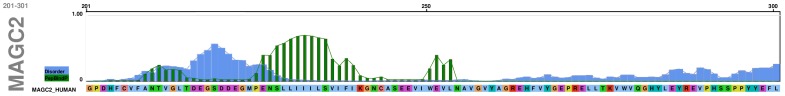
PepBindPred output for Q9UBF1 (MAGC2_HUMAN).Melanoma-associated antigen C2; Motif: LLIIILSVI, residues 229–237.